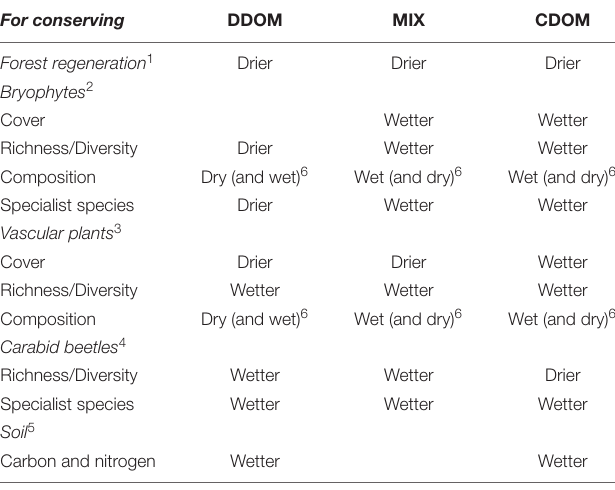
TABLE 3 | Associations between soil wetness, biodiversity and ecosystem function (soil carbon and nitrogen) for three stand types in boreal mixedwood forest.